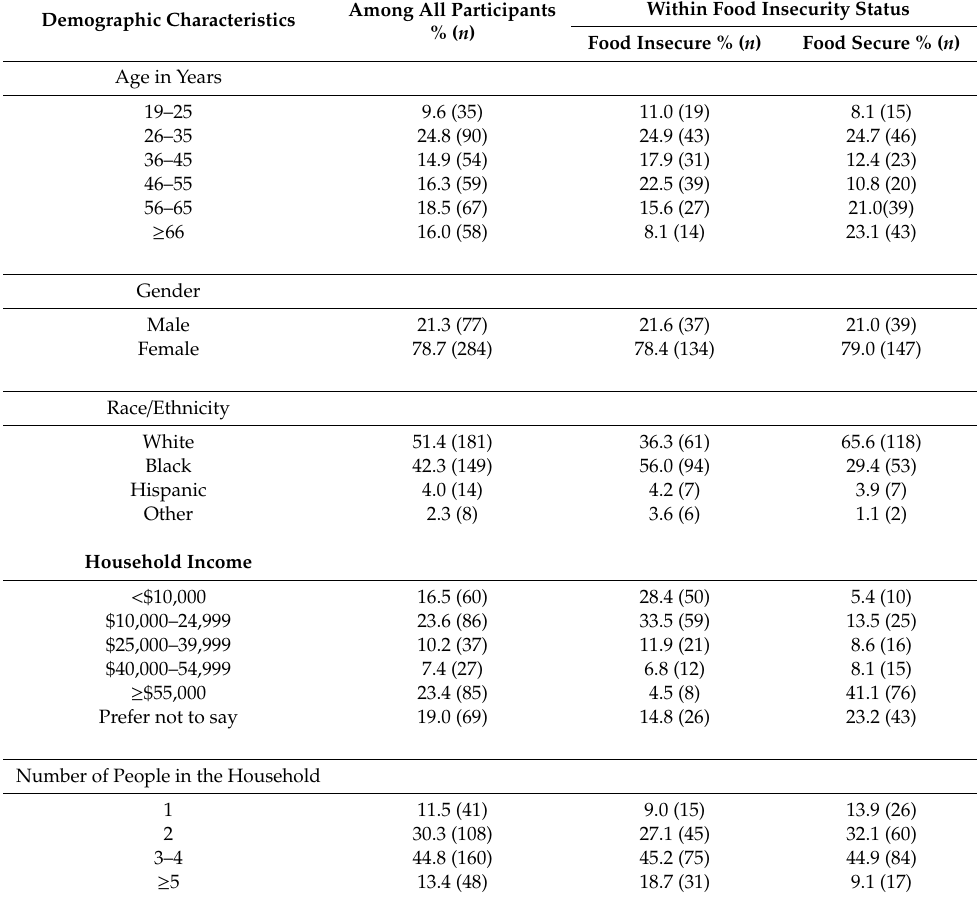
Table 1. Demographic distributions of all participants and by food security status ( N = 370)